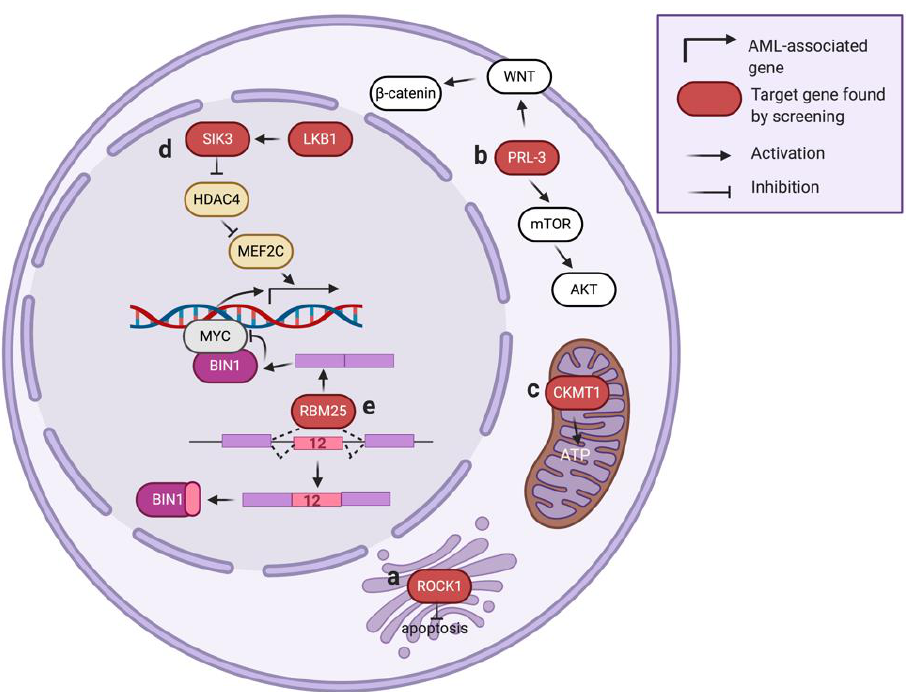
Figure 3. Kinases and gene expression-related genes identified via high-throughput genetic screens in